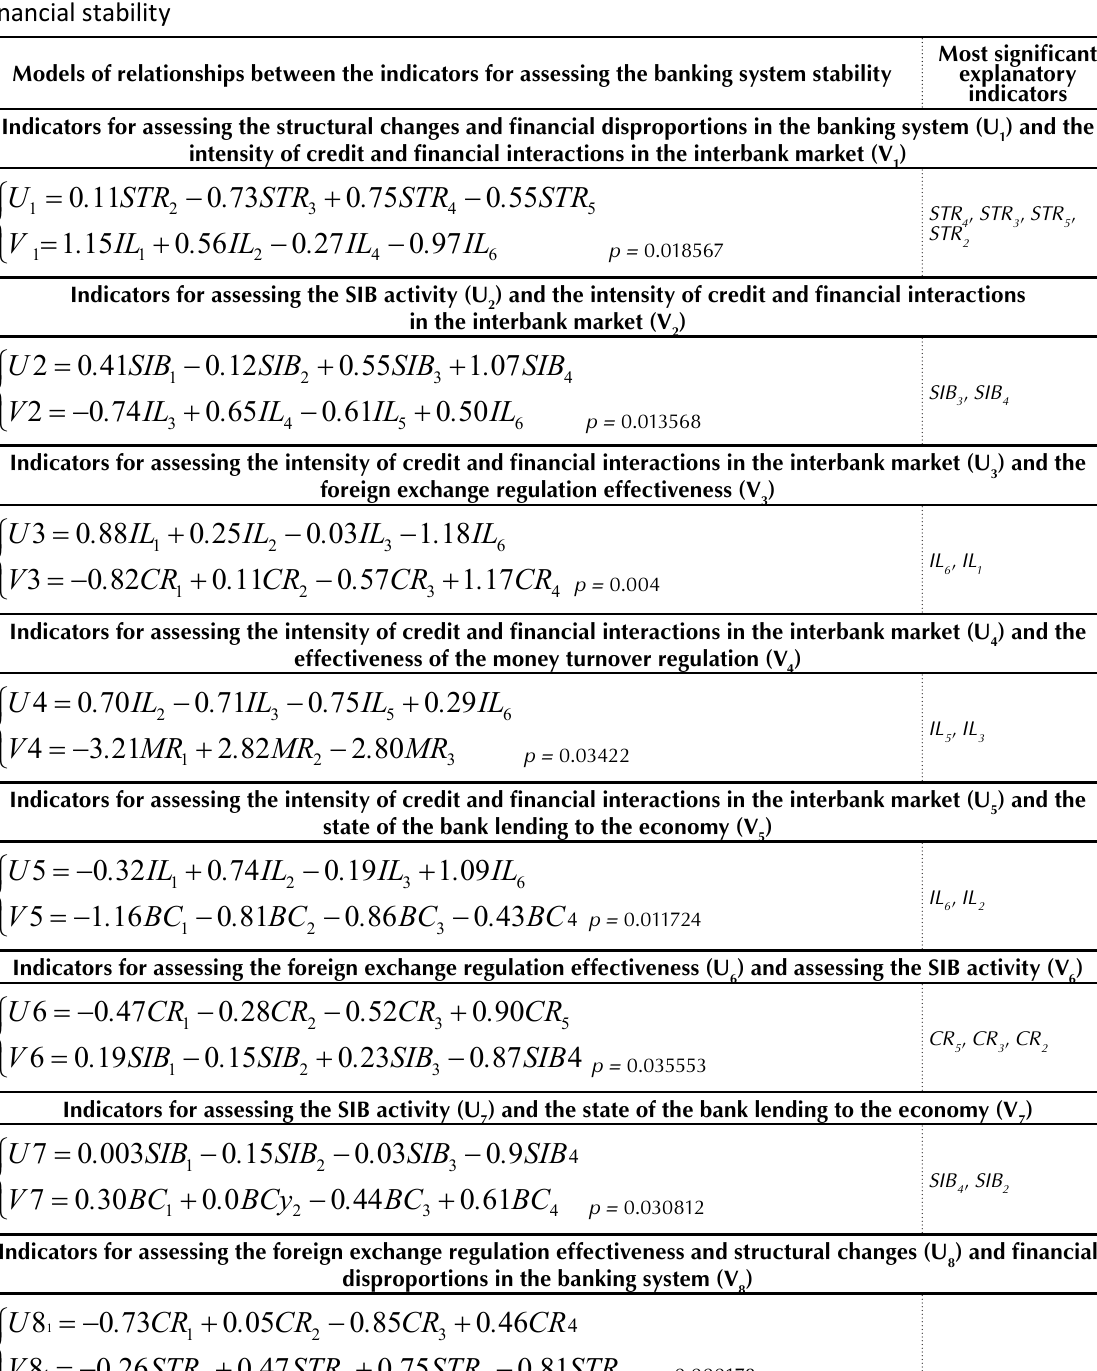
disproportions in the banking system (V